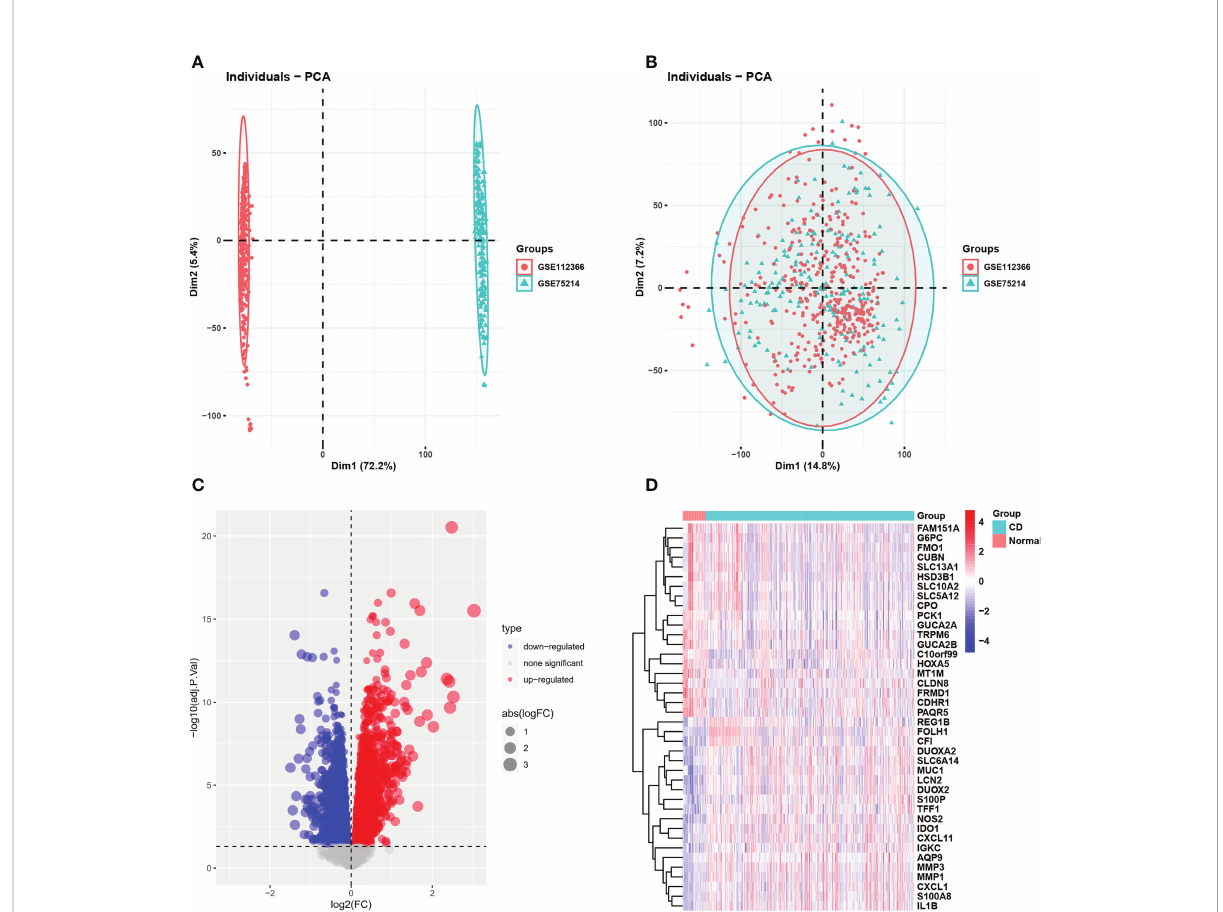
FIGURE 1 GEO dataset combination and differentially expressed genes. (A, B) PCA showed the batch effect between integrated datasets before and after de-batching. (C) The volcano plot of CD-related DEGs. (D) Clustered heatmap of CD-related DEG expression levels. GEO, gene expression omnibus; PCA, principal component analysis; CD, Crohn ’ s disease; DEGs, differentially expressed